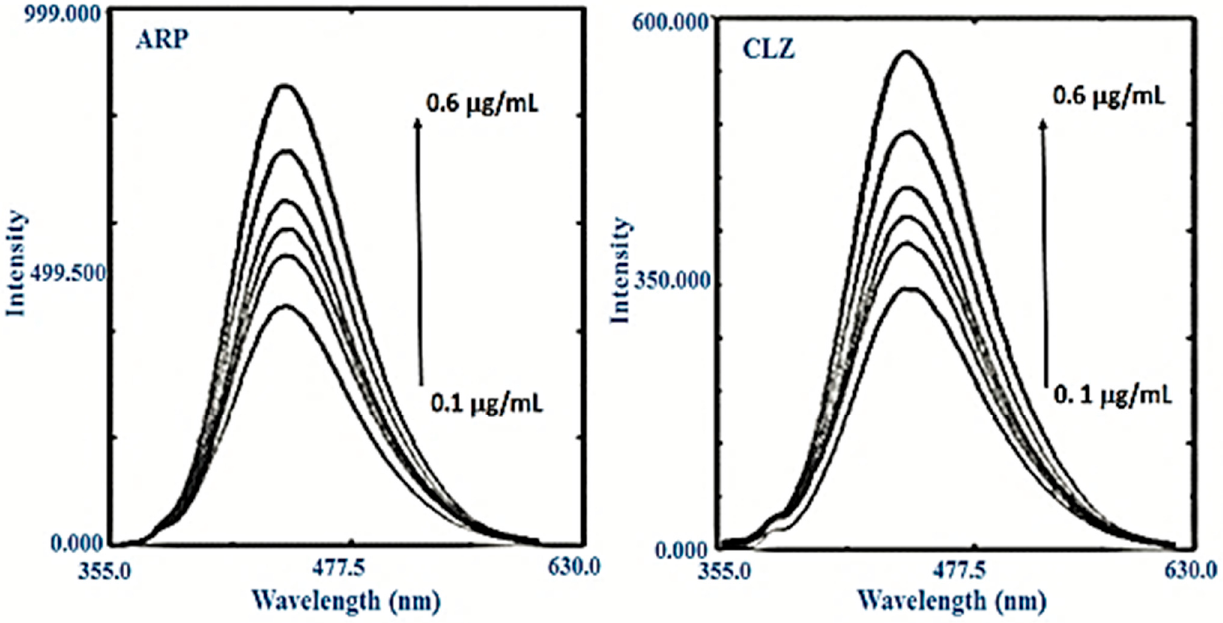
Figure 6. Emission spectra of o -phthalaldehyde with increasing ARP and CLZ concentrations (0.1–0.06 µ g/mL) in buffer borate.